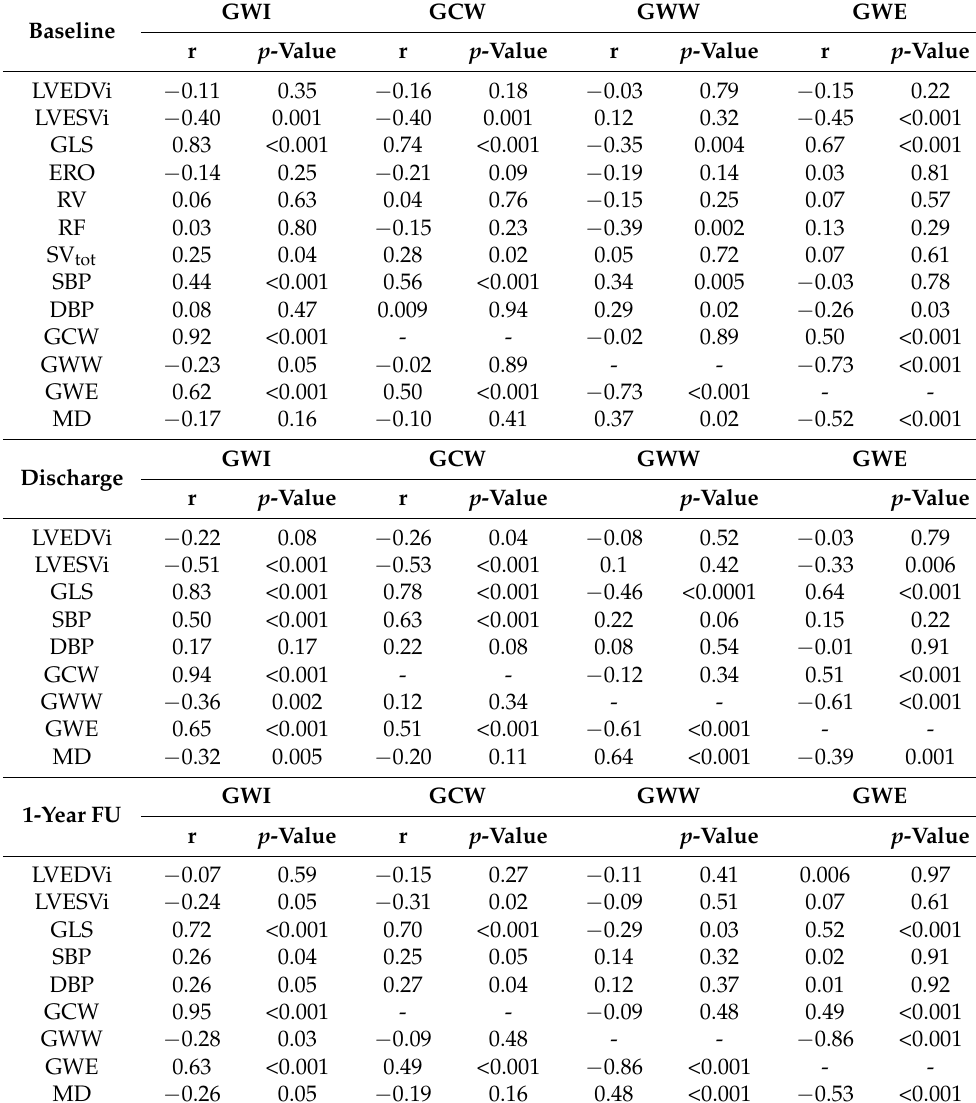
Table 2. Main correlates of myocardial work indices at baseline, hospital discharge, and 1-year